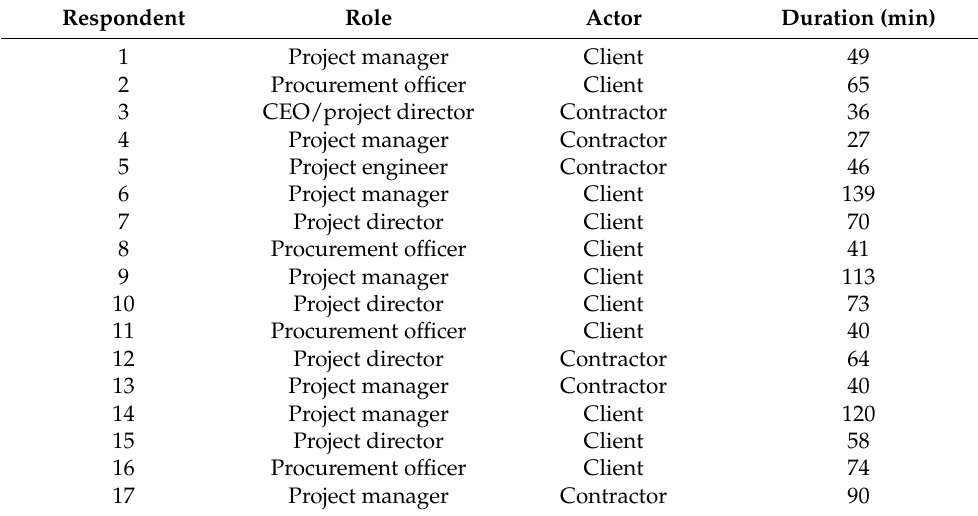
Table 1. Information on the interviews and